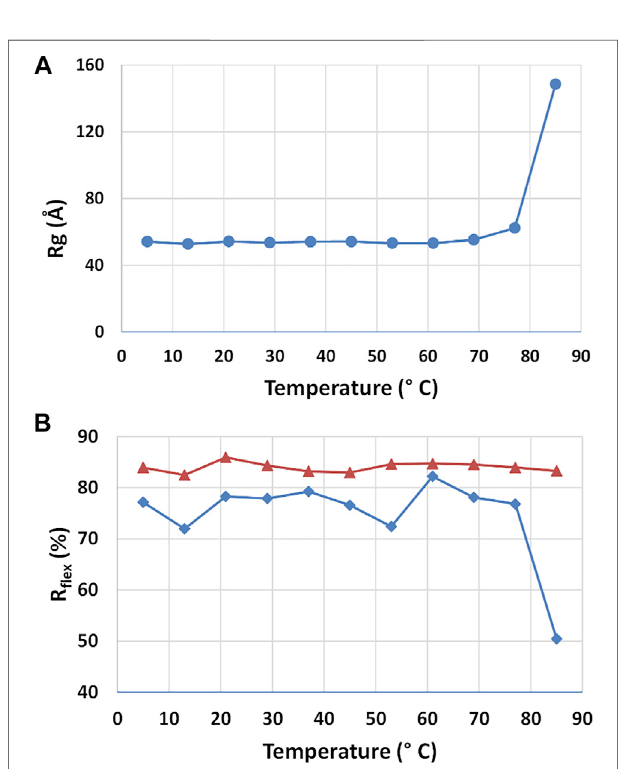
FIGURE 8 | Results of the SAXS analysis of data taken at different temperatures.Radiusofgyration R g (A) and R fl ex parameterdeterminedbythe ensemble optimization method for the selected structures (blue line) and the pool of generated structures (red line) (A)